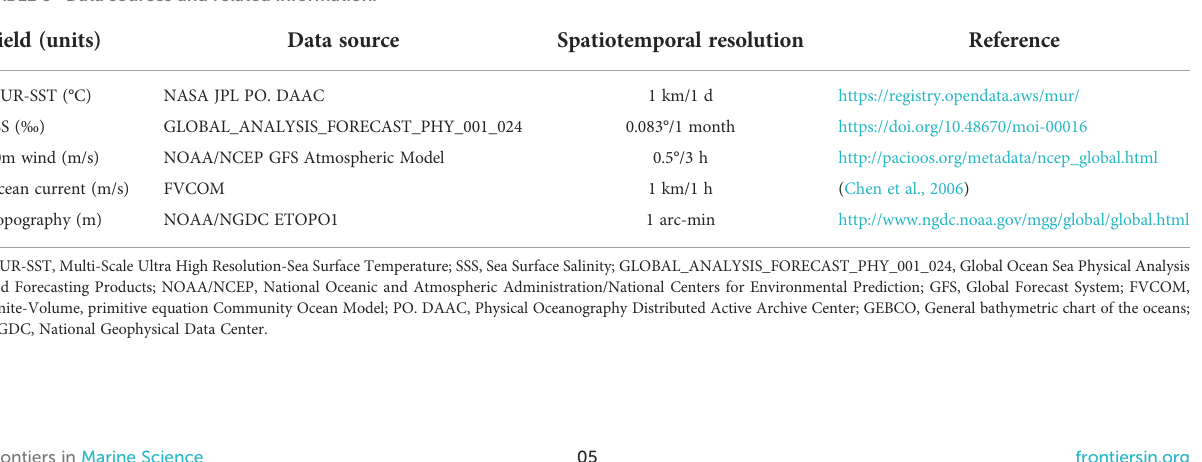
TABLE 3 Data sources and related